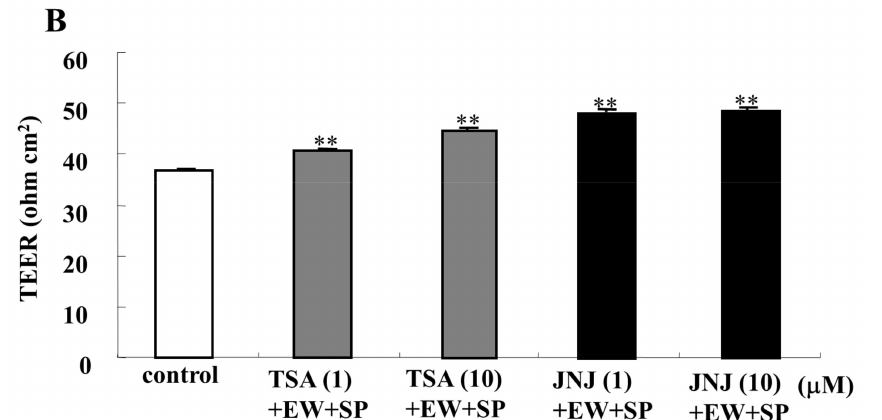
Figure 2. ( A ) Transmission electron microscopic (TEM) analysis of A253 cells treated with or without TSA and JNJ at 10 µ M in the presence of EW-7197 and SP600125 at 10 µ M Scale bar: 2 µ M. ( B ) Bar graph TEER values representing barrier function in A253 cells treated with TSA and JNJ at 1 and 10 µ M in the presence of EW-7197 and SP600125 at 10 µ M. p ** <0.01.